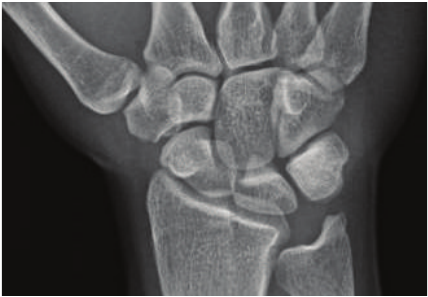
Figure 1: Posteroanterior radiographic view of the wrist at the time of initial evaluation that shows no abnormality in the scaphoid.